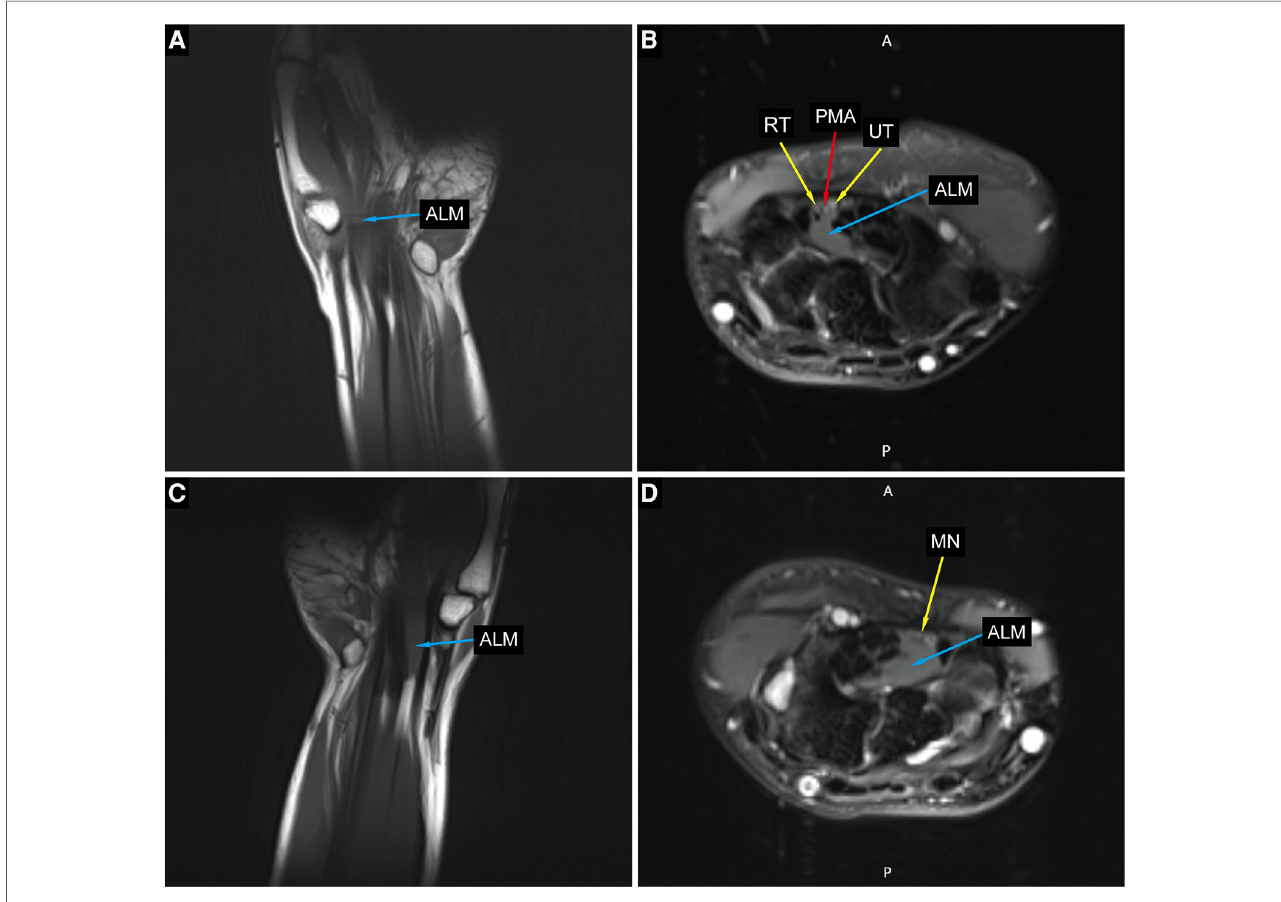
FIGURE 3 Preoperative MRI imaging of the bilateral hands and wrists. ( A,C ) Coronal sections of the left and right hand show an anomalous lumbrical muscle in carpal tunnel. ( B ) Axial section at left hamate hook level showing anomalous lumbrical muscle, bi fi d median nerve with persistent median artery. ( D ) Axial section at right hamate hook level showing anomalous lumbrical muscle and compressed median nerve. ALM, anomalous lumbrical muscle; RT, radial trunk of the median nerve; UT, ulnar trunk of the median nerve; PMA, persistant median artery; MN, median